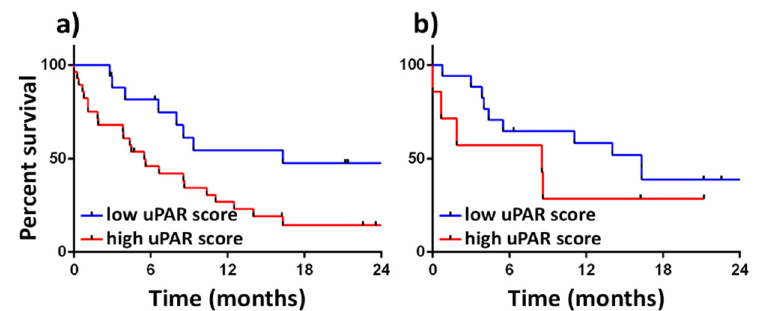
Figure 2. Kaplan-Meier curve showing association of GOC tumour uPAR score and overall survival (OS). Low uPAR (0–1) and high uPAR expression (>2) on tumour cells assessed by immunohisto- chemistry (IHC) at ( a ) tumour invasion front (n = 43; p = 0.02) and ( b ) tumour core (n = 24; p =